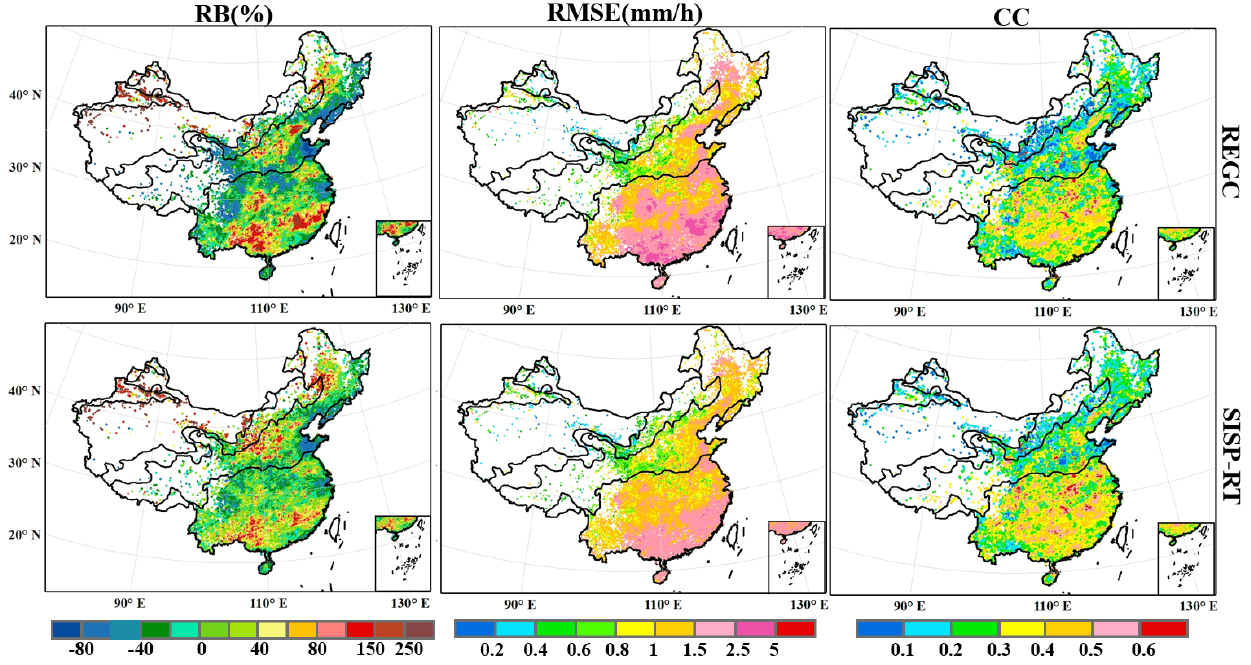
Figure 7. Spatial patterns of RB (first column), RMSE (second column), and CC (third column) of the REGC and SISP-RT against the CMPA over Mainland China.